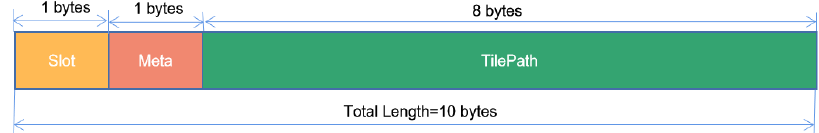
Figure 4. Structure of the row key Storing Tiles.